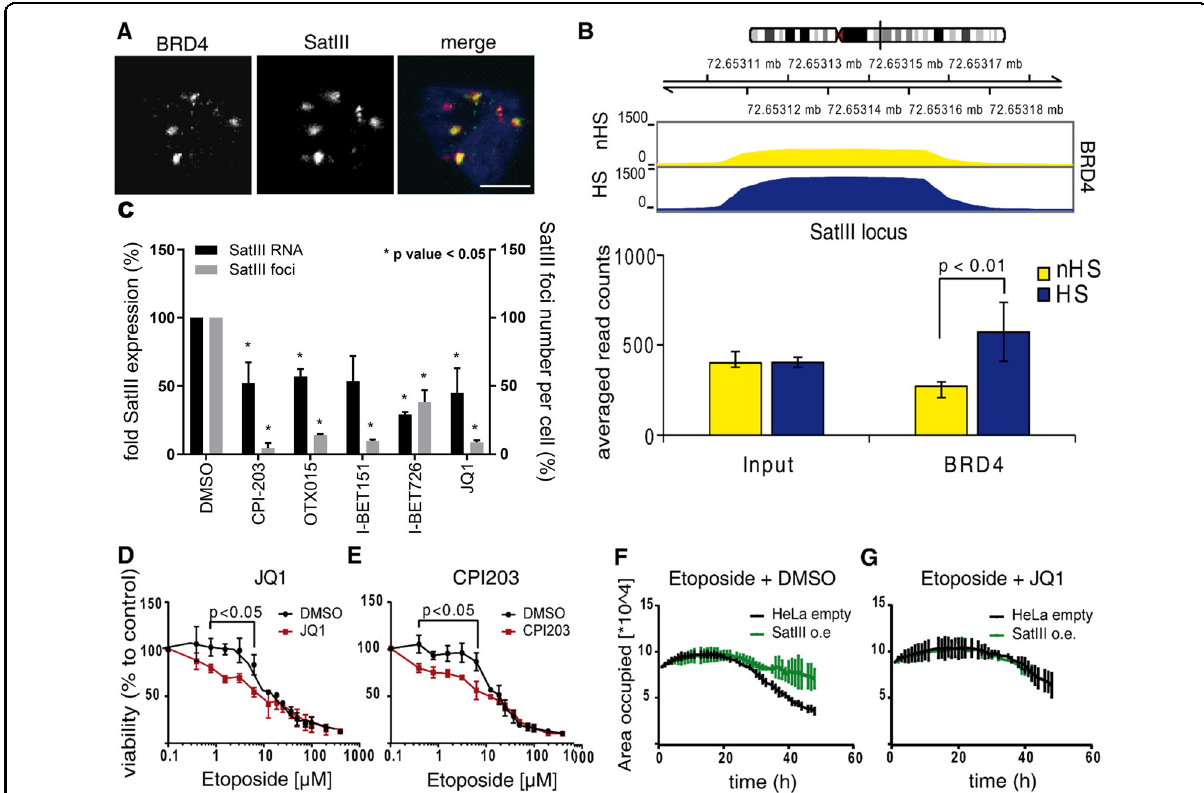
Fig. 4 BET protein inhibitors revert etoposide resistance through SatIII regulation. A Representative images of co-localization of SatIII RNA and BRD4 after exposure to HS conditions (1 h at 44 °C). Immediately following HS, cells were fi xed, immunostained, and imaged. SatIII was stained with smFISH (red), BRD4 with a protein-speci fi c antibody (green). Scale bar, 10 µm. B Binding of BRD4 to the SatIII DNA locus after HS (1 h at 44 °C). For the ChIP-Seq experiment cells were subjected to HS or control conditions. ChIP was performed with a BRD4-speci fi c antibody. C Effect of BRD4 inhibition on SatIII expression. HeLa cells were treated with various BRD4 inhibitors and exposed to HS conditions (1 h at 44 °C). Two read-out methods were applied: RNA expression was measured by qPCR and RNA FISH was used to quantify SatIII RNA foci. Values of non-treated cells (DMSO control) were set to 100%. Error bars represent SD of the mean of n = 2 independent replicates. P -values < 0.05 marked with (*). Signi fi cance was determined using two-tailed paired Student ’ s t-test. D Cell viability of HeLa cells treated with etoposide and the BRD4 inhibitor JQ1 (1 µM) or DMSO as control. Directly after exposure to HS (1 h at 44 °C), cells were treated with the indicated etoposide concentrations in combination with JQ1. After an additional 48 h, cell viabilities were measured using AlamarBlue. Error bars represent SD of the mean of n = 2 replicates. P -values <0.05 are marked with (*), Signi fi cance was determined using two-tailed unpaired Student ’ s t-test. E Same experiment as in (D) but with the BRD4 inhibitor CPI203 (1 µM). F Cell proliferation of HeLa cells either stably overexpressing SatIII RNA or an empty vector control. Cells were treated with 20 µM etoposide and cell proliferation was measured by acquisition of images every 30 min over a time course of 48 h. Con fl uency was analyzed with the cell pro fi ler software. G Cell proliferation assay performed as described in ( F ) but with a combination treatment of 20 µM etoposide and 5 µM